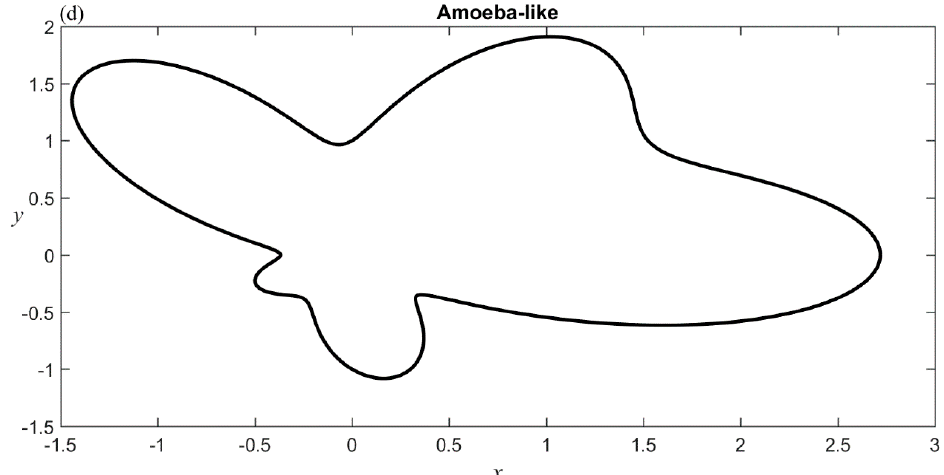
Figure 1. Four geometric configurations of the Allen-Cahn (AC) equation in heat transfer of thin films are shown in ( a ) the peanut shape, in ( b ) the Cassini shape, in ( c ) the gear irregular shape, and in ( d ) the amoeba-like irregular shape.